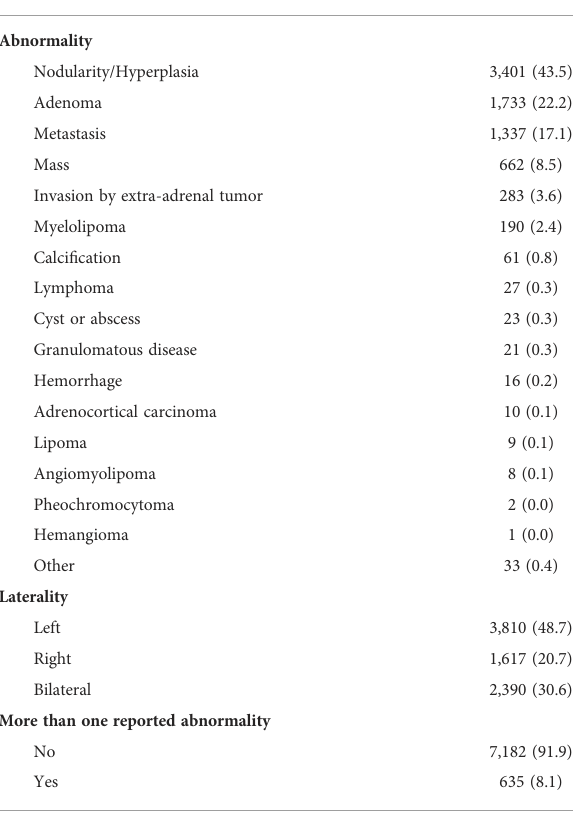
TABLE 2 Description of adrenal abnormalities in abdominal computed tomography imaging reports obtained within 30 days of